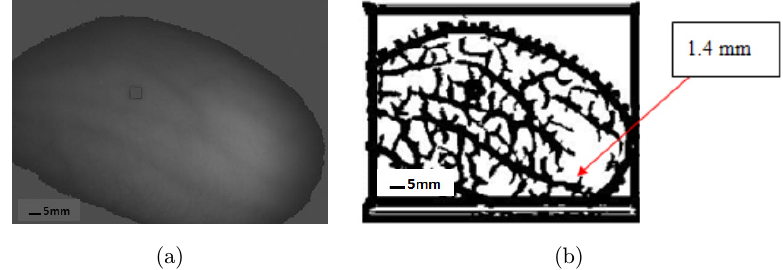
Fig. 11. In-vivo imaging results (arm region); (a) Raw images, (b) Processed image.